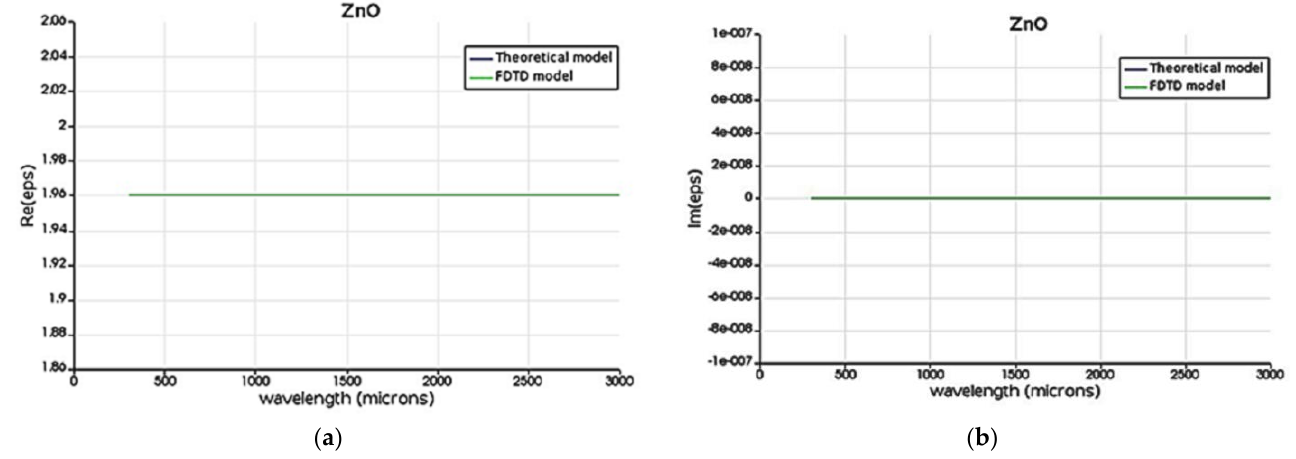
Figure A4. Dielectric constant of ZnO: ( a ) The real part of the dielectric constant; ( b ) The imaginary part of the dielectric constant.